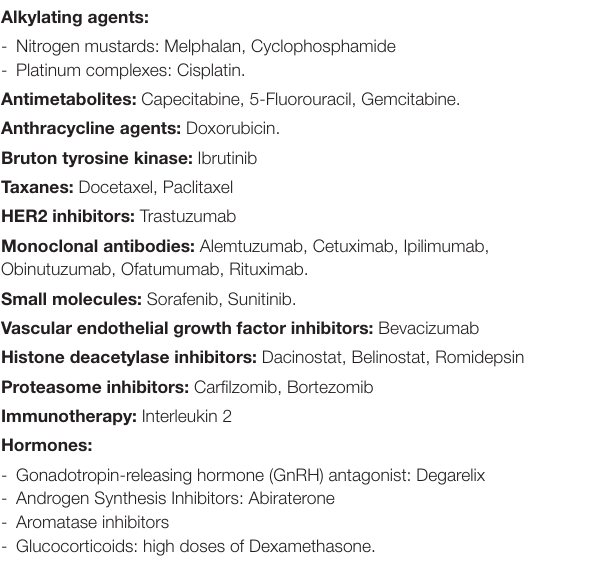
TABLE 1 | Anti-cancer drugs related to atrial fibrillation. Alkylating